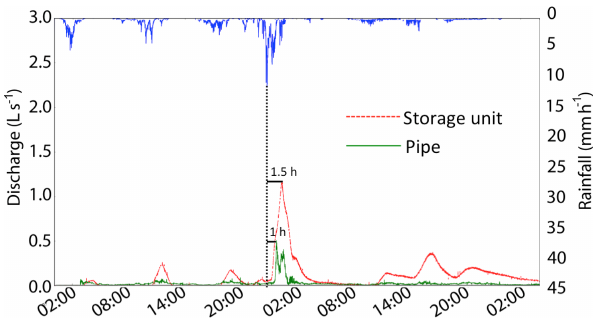
Figure 7. Rainfall and computed discharges for the 29– 30 April 2018 event.